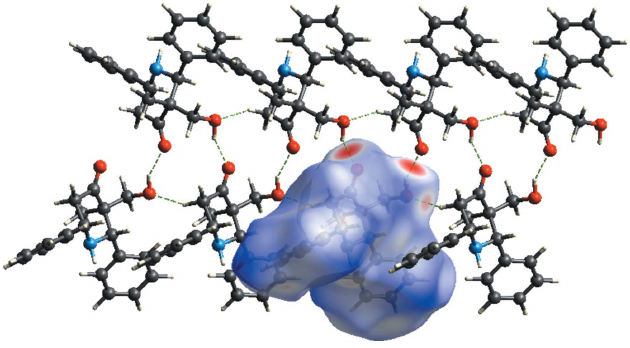
Figure 3 The red spots on the d norm surface of the title structure represent the O— H (cid:3)(cid:3)(cid:3) O and C—H (cid:3)(cid:3)(cid:3) O intermolecular